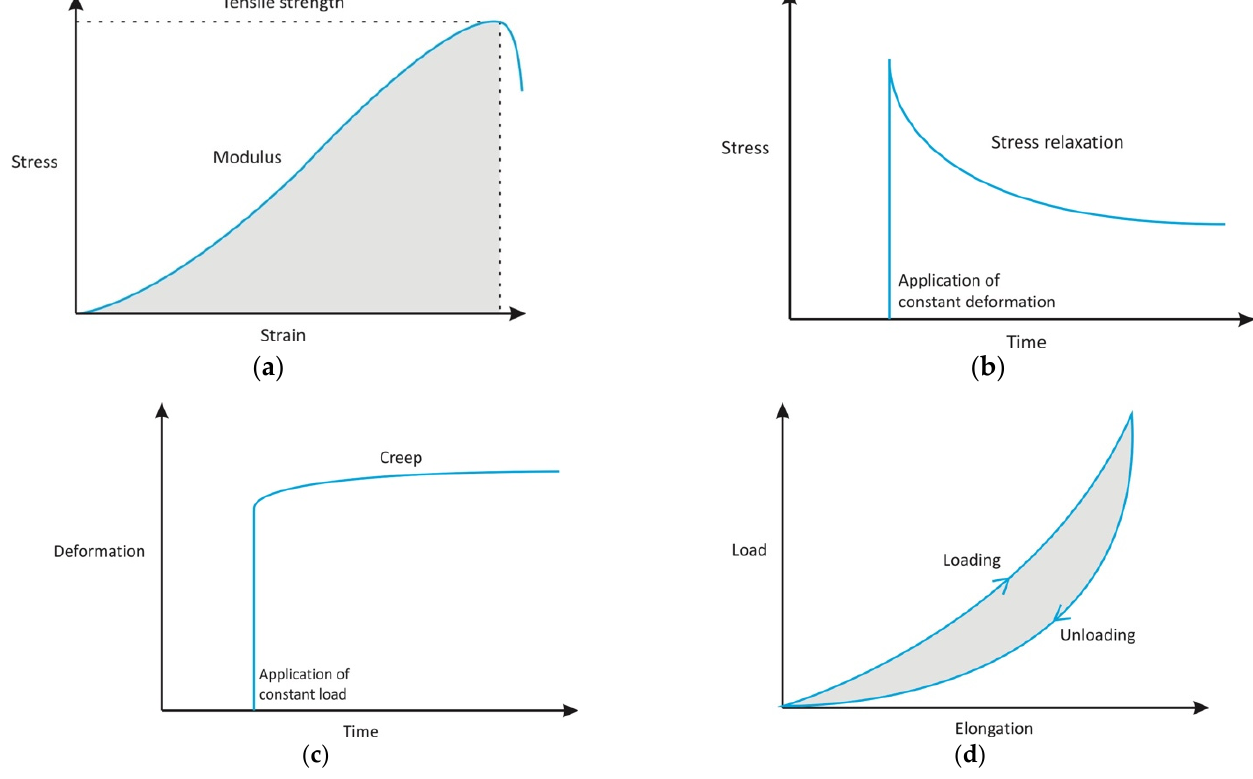
Figure 5. ( a ) Shows stress-strain curve. ( b – d ) Shows the schematic diagrams characterising tissues with viscoelasticity. ( b ) Shows relaxation. ( c ) Shows creep in this context deformation is meant as strain. ( d ) Shows the hysteresis loop. Elongation is meant as strain value. Figures obtained with permission from [41].